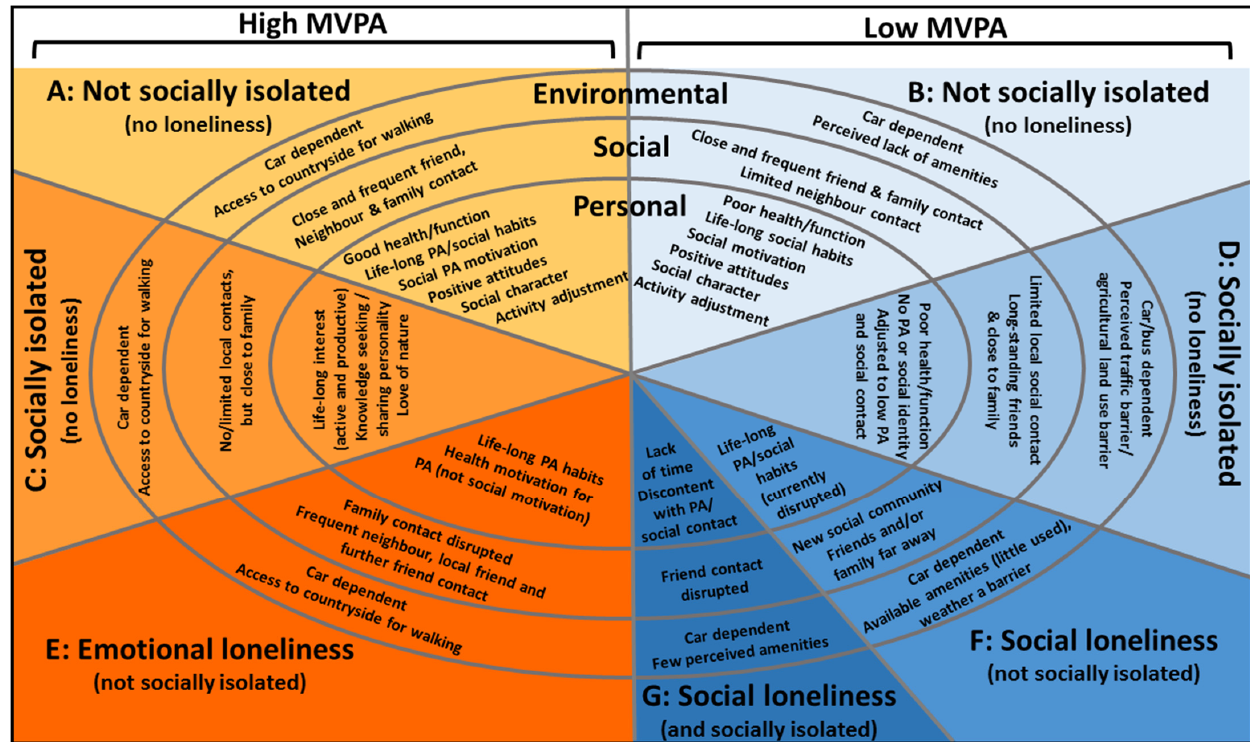
Figure 1. Socioecological characteristics observed in different MVPA, social isolation and loneliness profiles. The personal domain contains both characteristics relating to the present time (e.g., health) and previous life-stages (e.g., life-long habits of PA). Themes affecting high-MVPA participants are displayed on the left, and those affecting low-MVPA participants on the right side of the figure.